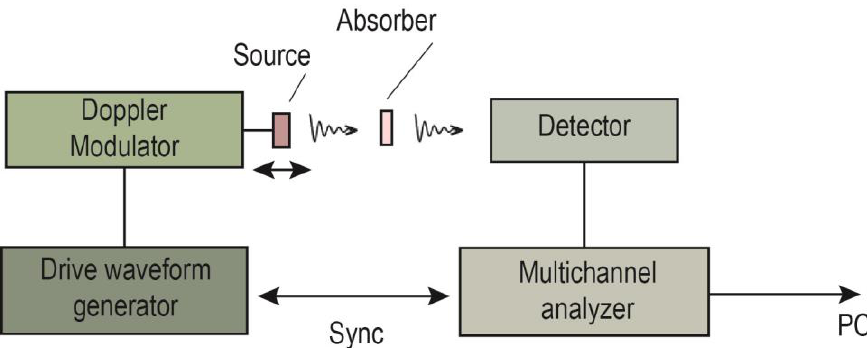
Figure 4. Scheme of the Mössbauer experiment in the transmission geometry.